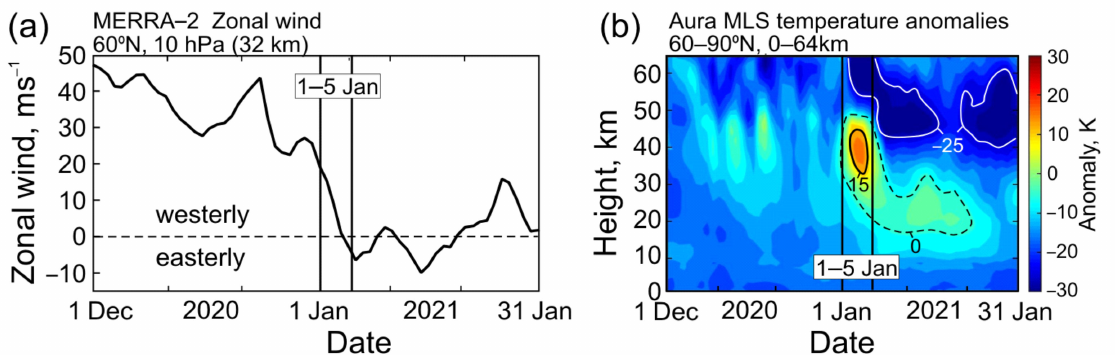
Figure 1. ( a ) Zonal wind in the middle stratosphere at 10 hPa (32 km) at 60 ◦ N latitude from the MERRA-2 data (dashed horizontal line indicate zero wind) and ( b ) time–height variations of temperature anomalies in the polar cap (60–90 ◦ N) from the Aura MLS data relative to climatology 2004–2020. The vertical lines indicate the time interval of 1–5 January 2021 when the SSW event